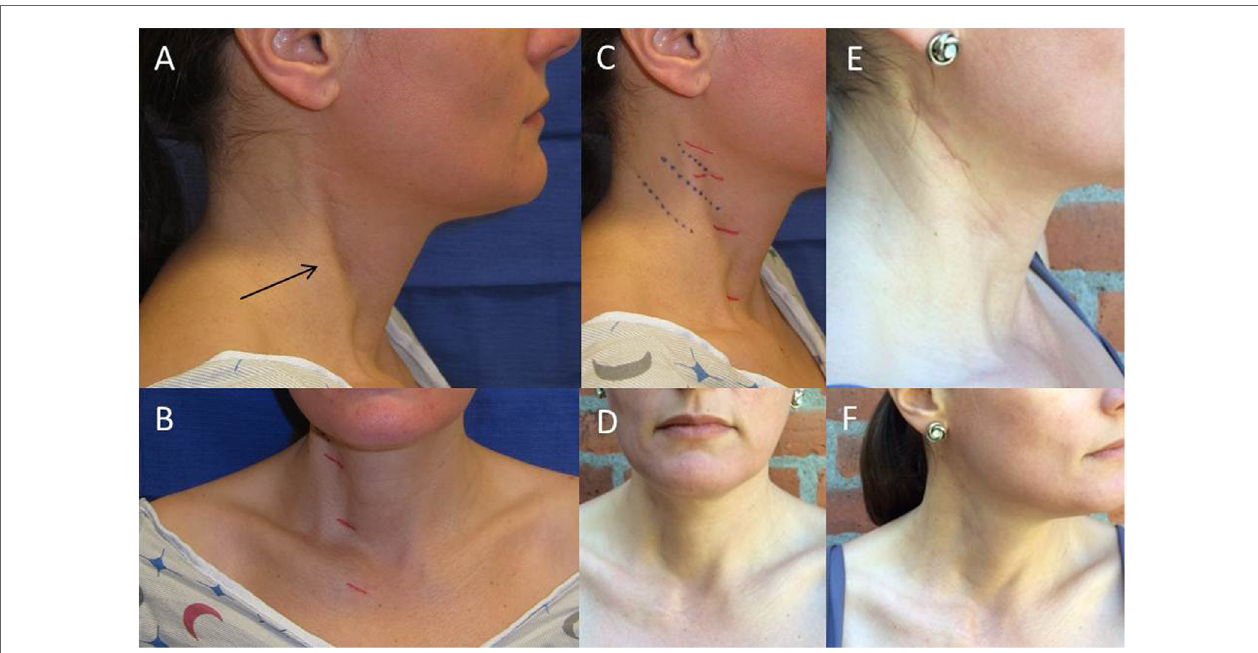
FIGURe 1 | Images of tethering and anterior sCM defect pre-operatively and post-operative resolution of marked tethering and appearance of incision. Noticeable tethering from the lateral view marked with an arrow (a) and from the anterior view with previous stair-step incision marked in red (B) . Lateral view of pre-operative planning for Z-plasty incision with Langer lines indicated in blue (C) . Two views of post-operative decrease in tethering (D,F) . Post-operative appearance of Z-plasty incision at 6 months (e)